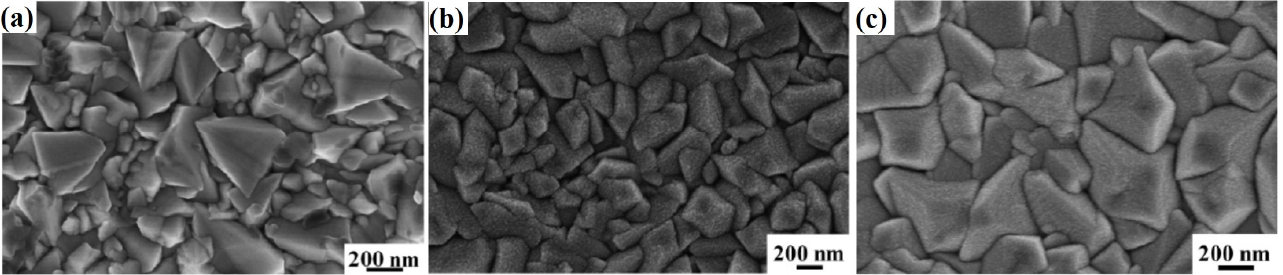
Figure 1. SEM images of bare FTO surface ( a ) and of the FTO surface covered with the 17.6-nm-thick Pd film ( b ) and by the 48.6-nm-thick Au-Pd film ( c ). Pd film ( b ) and by the 48.6-nm-thick Au-Pd film ( c